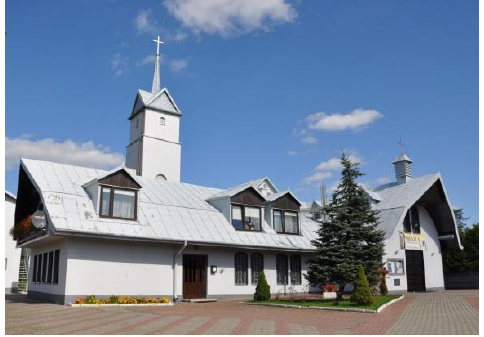
Figure 6. Church of John the Baptist in Radomsko (built in 1989–92).